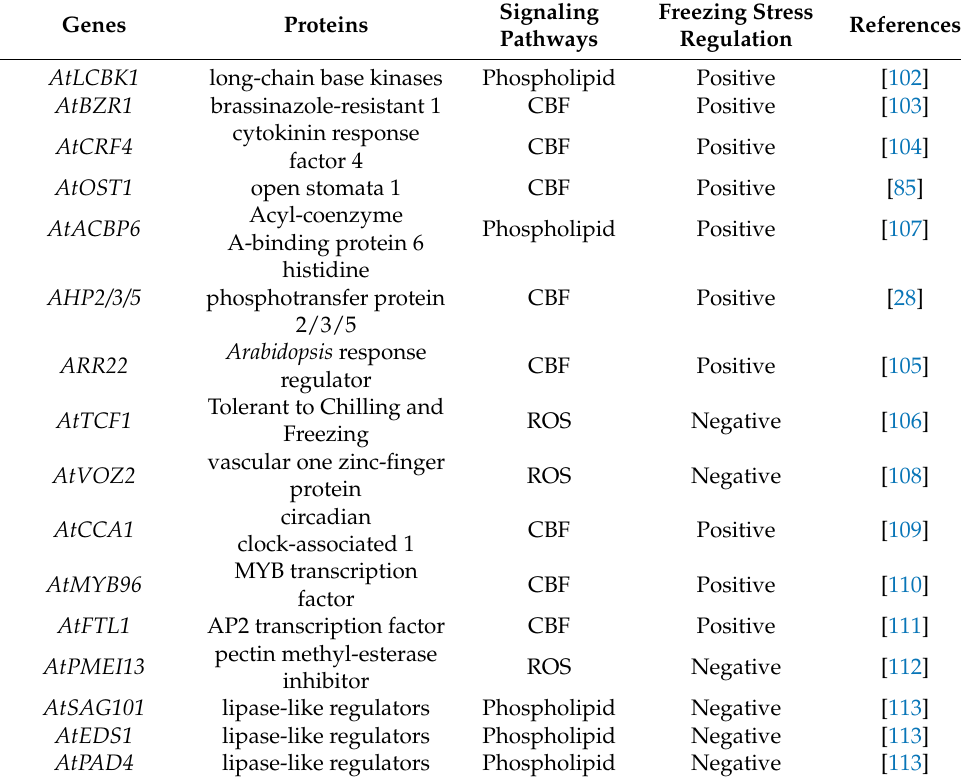
Table 1. List of transgenic freezing stress Arabidopsis lines since